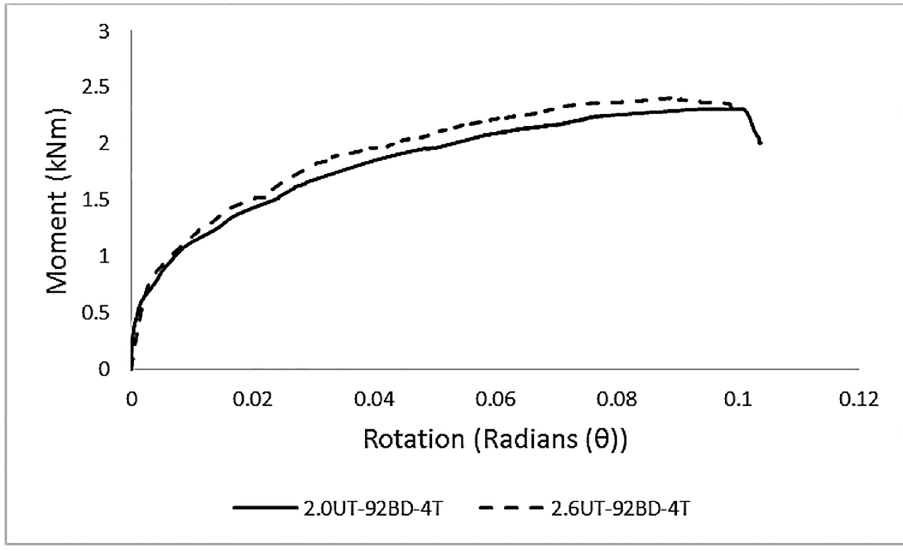
Fig 11. Effect of varying column thickness with constant beam depth and number of tabs in the beam end connector.